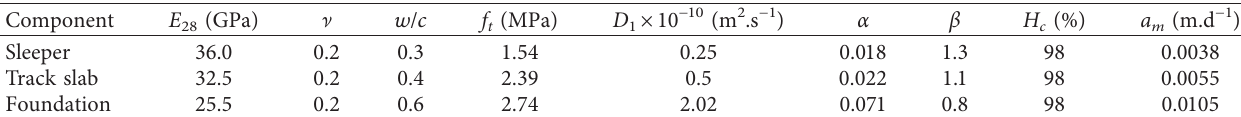
Figure 8: Early humidity field calculation model of CRTS I bi-block ballastless track. (a) Overall FE model and (b) local schematic for the cross section I-I. Table 1: Material